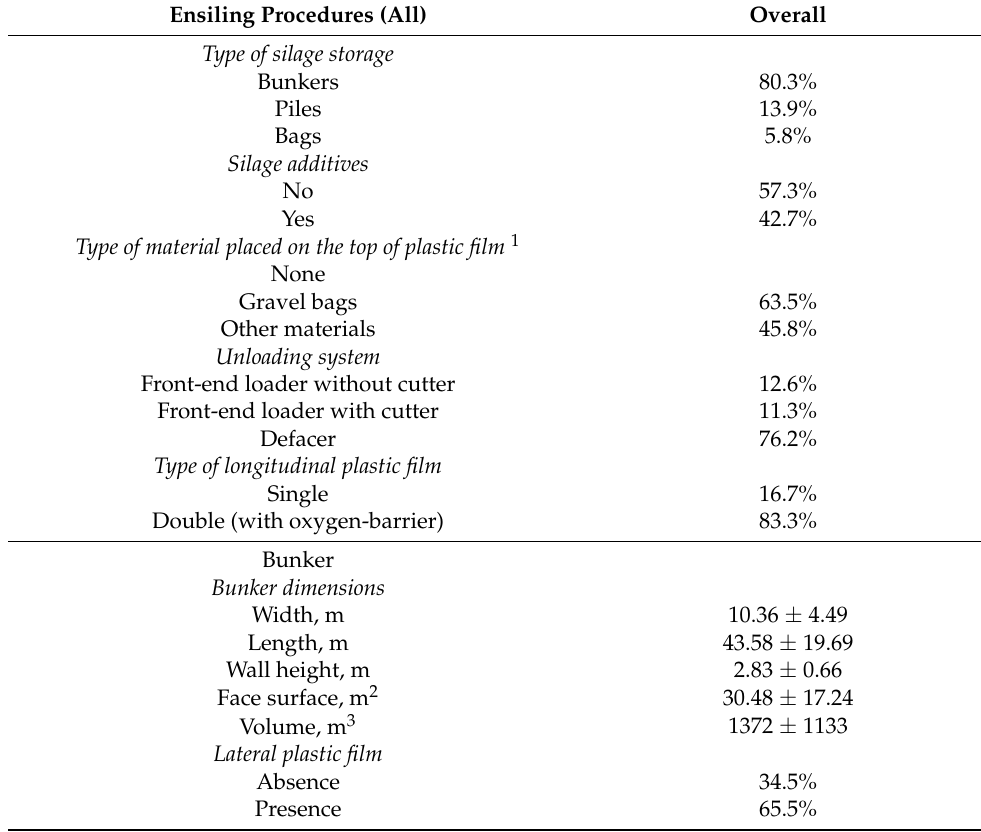
Table 2. Main ensiling procedures recorded for each silo ( n =